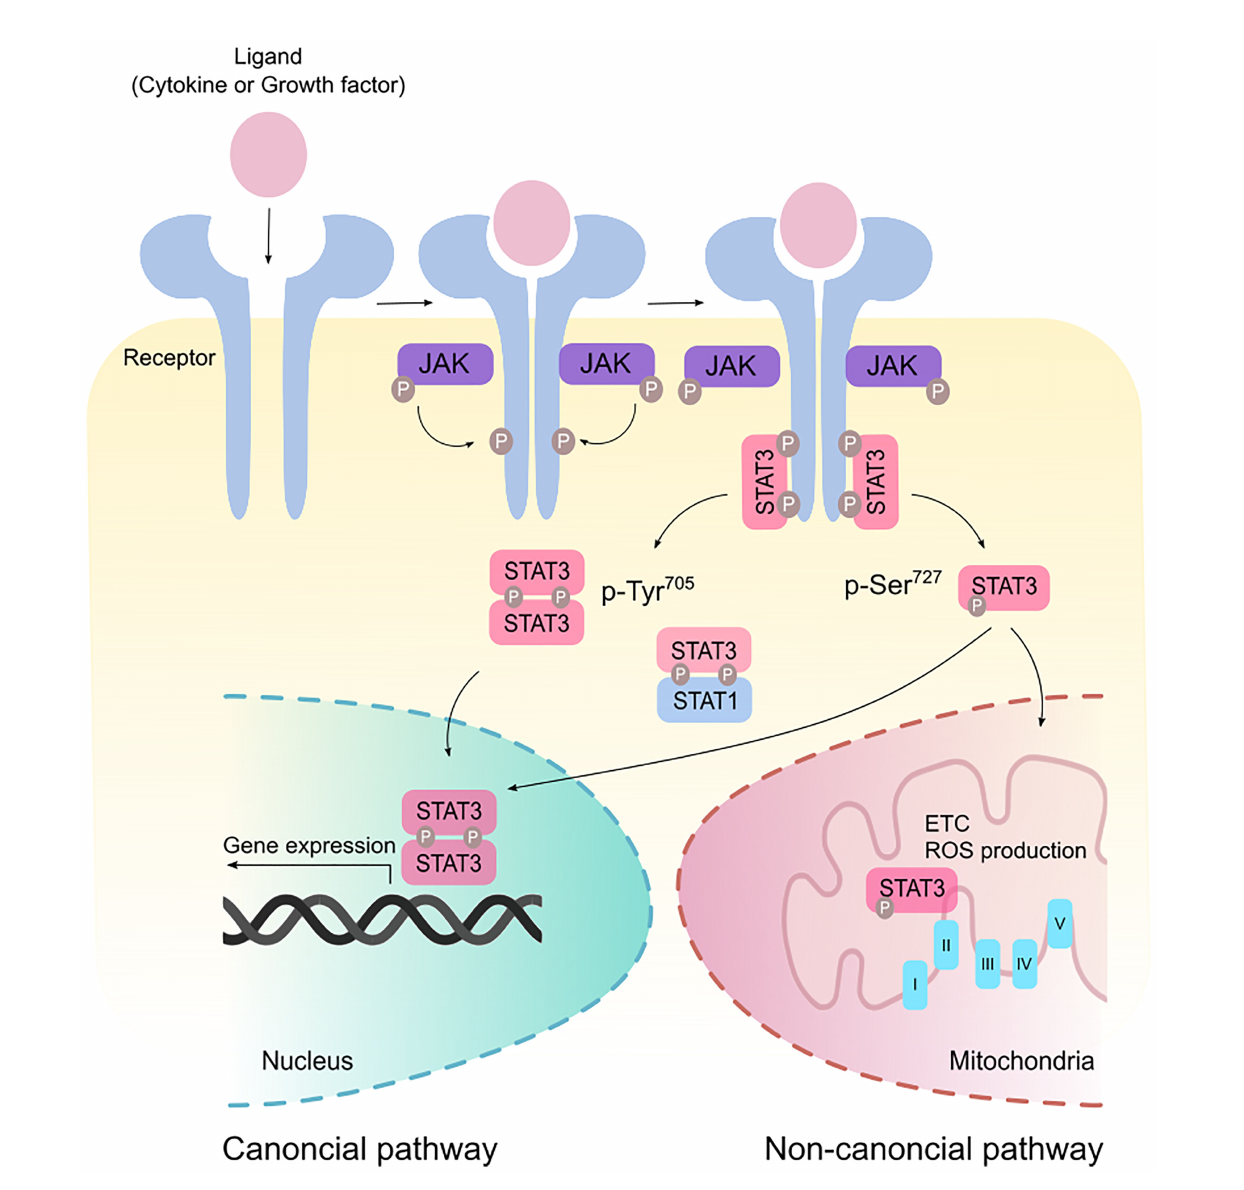
FIGURE 1 | Canonical and non-canonical STAT3 signaling. Binding of ligands such as cytokines and growth factors to their cognate receptors stimulate receptor dimerization and recruitment of Janus kinase (JAK). JAK phosphorylates the cytoplasmic tails of the receptor to create a docking site for STAT3. In the canonical pathway, STAT3 is phosphorylated at the Tyr 705 residue and form homodimers or STAT3:STAT1 heterodimers that modulate gene expression in the nucleus. Maximal transcriptional activation can also be induced by the non-canonical activation of STAT3 via phosphorylation at the Ser 727 residue. p-Ser 727 STAT3 can then translocate to the mitochondria to regulate the electron transport chain (ETC) and production of reactive oxygen species